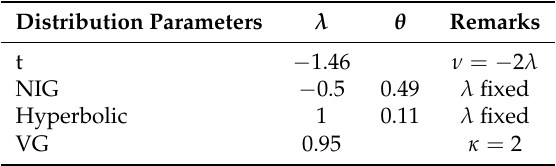
Table 1. Distribution parameters used in the calculation experiments. These have been derived by fitting these distributions to two-weekly log-returns of the S&P500 index over the period from 17 July 2007 to 31 December